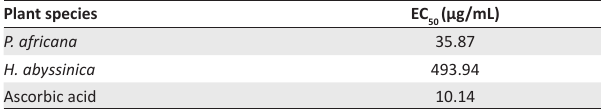
TABLE 6: EC values for Prunus africana and Harrisonia abyssinica. 50